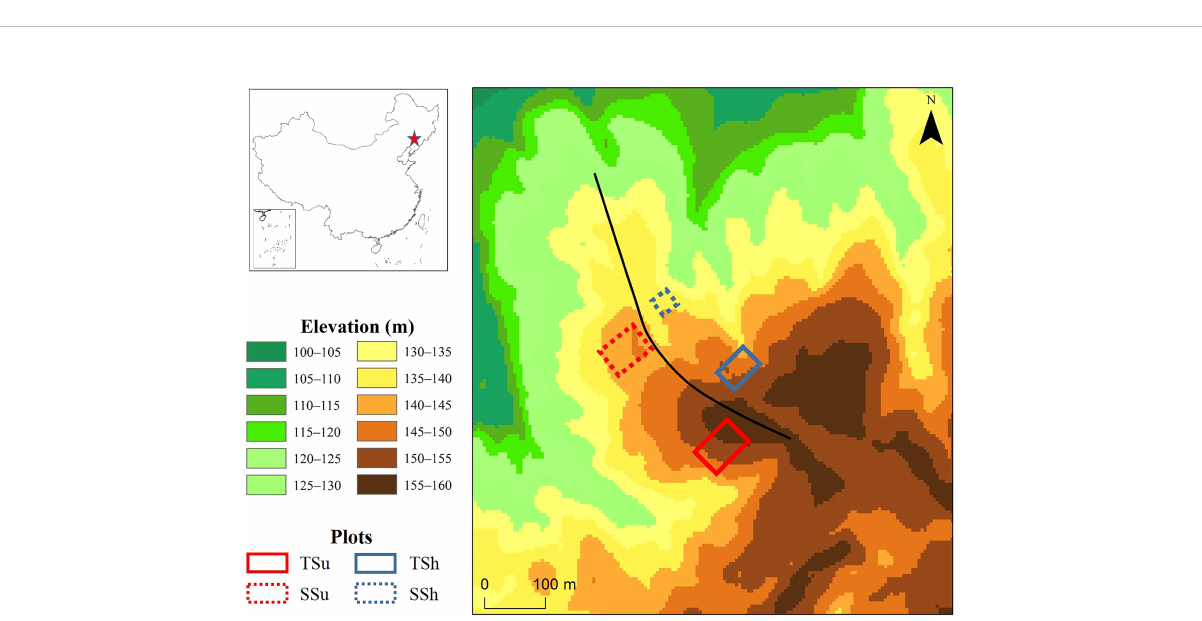
FIGURE 1 Site information and the topography of sample plots. The dashed squares indicate the hillside, and the solid squares indicate the hilltop. The red squares denote the sunny slope, and the blue squares denote the shady slope. The black curve represents the ridge line. The red star represents the study